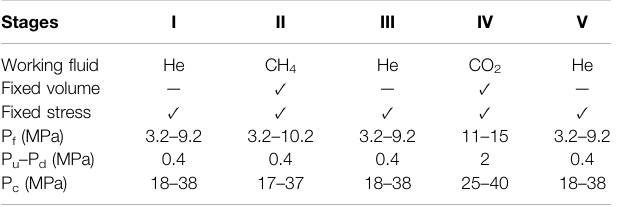
TABLE 1 | Experimental lists indicating the working fl uid, boundary conditions, mean pore fl uid pressure ( P c ) employed in the fl ow-through tests, pressure difference between upstream and downstream ( P u – P d ), and con fi ning pressure ( P c ) employed at fi xed stress for each